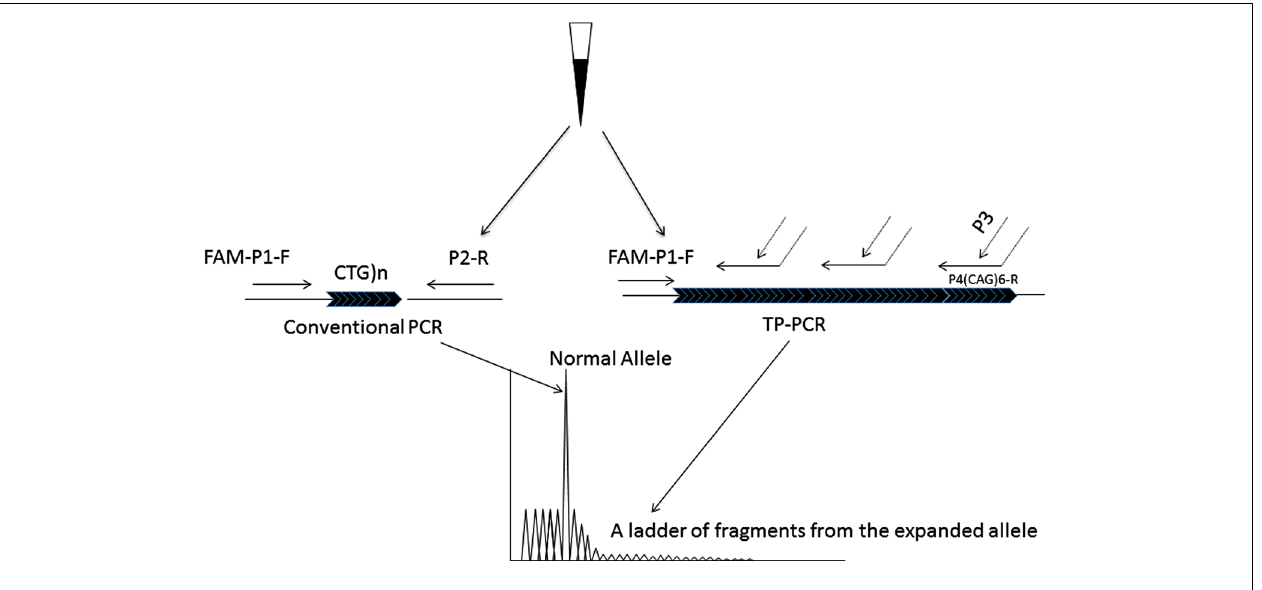
FIGURE 1 |The principle of the modifiedTP-PCR. Two PCR procedures, conventional PCR andTP-PCR are simultaneously carried out.The conventional PCR primers, P1-F and P2-R bind to the gene specific regions that closely flank the CTG repeat, generating the smaller alleles. Primer